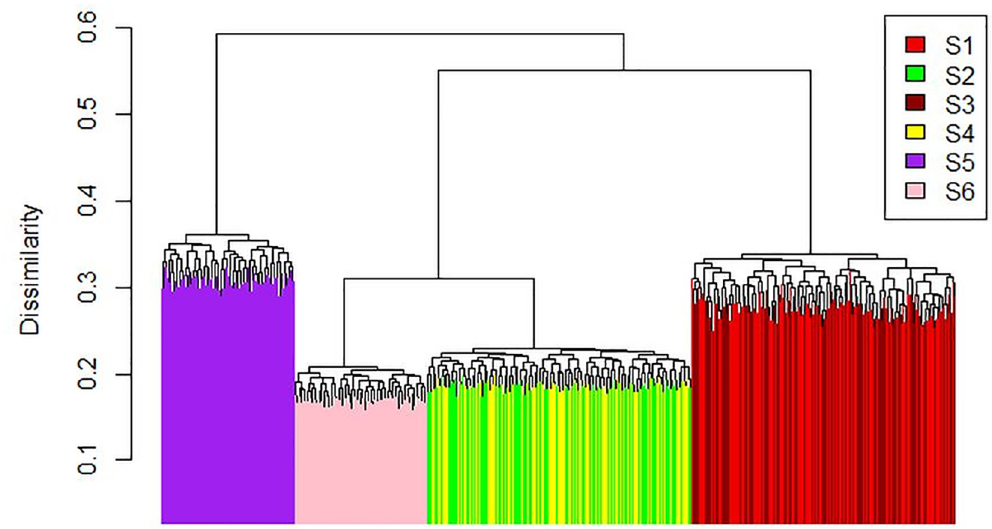
Fig 3. Dendrogram from a complete hierarchical cluster analysis based on a Jaccard resemblance matrix. S1 – S6 refer to the six scenarios: S1 Biodiversity features only, S2 Biodiversity features with existing sanctuary zones, S3 Biodiversity and resilience features, S4 Biodiversity and resilience features with existing sanctuary zones, S5 Resilience features only and S6 Resilience features with existing sanctuary zones.